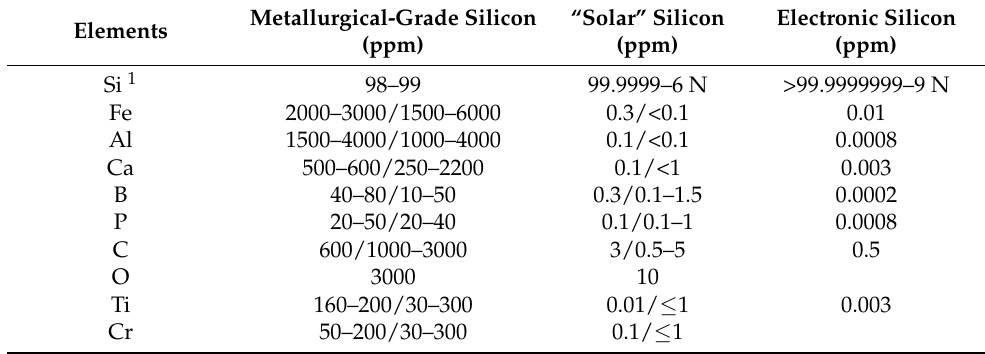
Table 1. Concentrations of impurities in various grades of silicon.